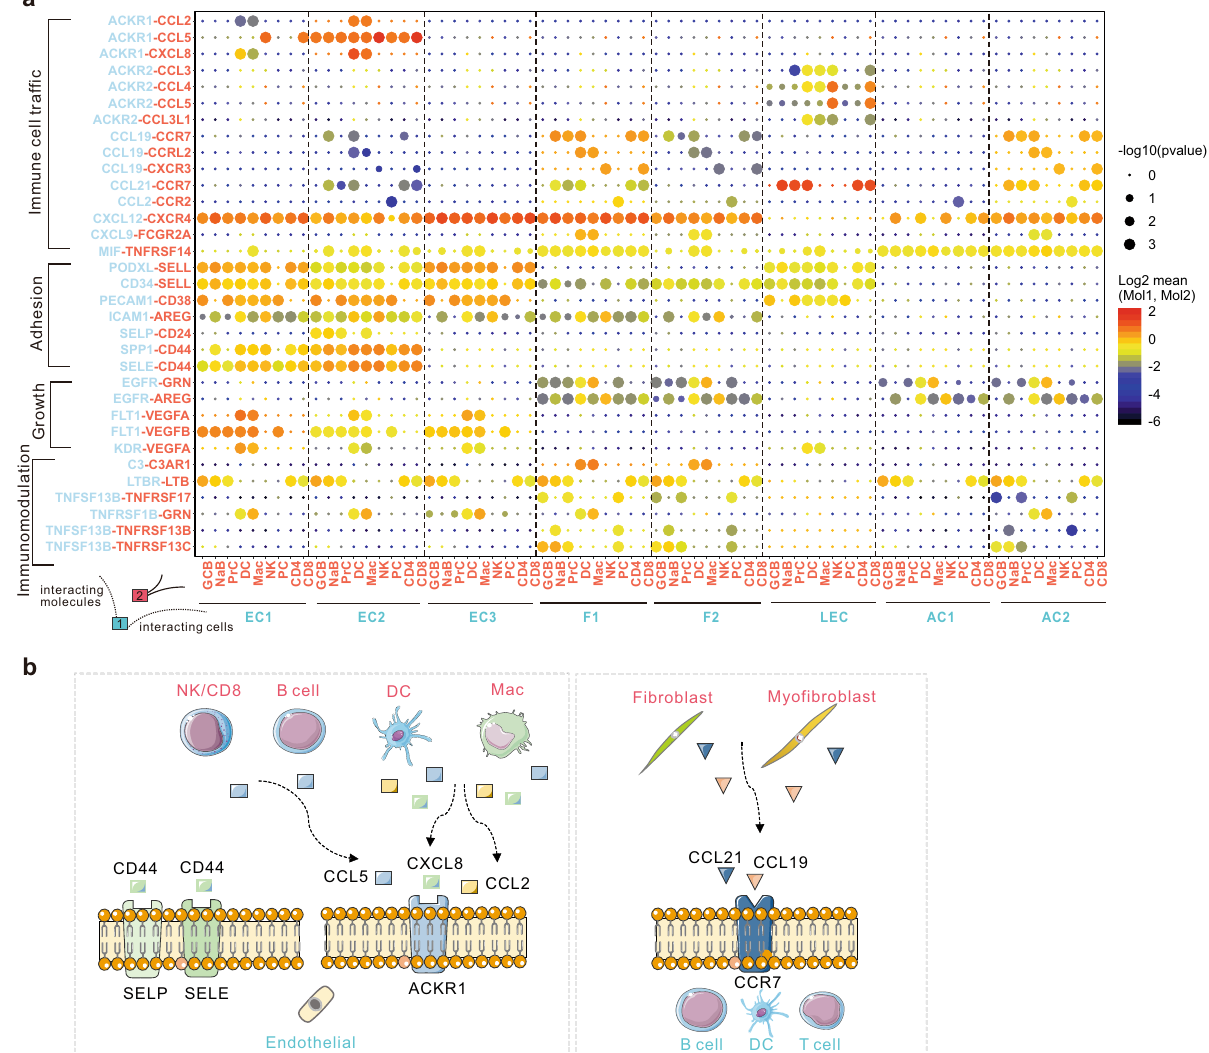
Fig. 3 Extensive cell interactions that may facilitate immune cell traf fi cking exist between stromal cells and immune cells. a Overview of selected ligand – receptor interactions between the thyroidal stromal cell subsets and immune cell clusters in thyroid tissues of HT patients. Circle size denotes corresponding p value of one-sided permutation test with 10,000 permutations. The means of the average expression level of interacting molecule 1 in cluster 1 and interacting molecule 2 in cluster 2 are indicated by color. b Diagram of the main receptors and ligands expressed on the thyroidal stromal cells and immune cells that are involved in adhesion and cellular